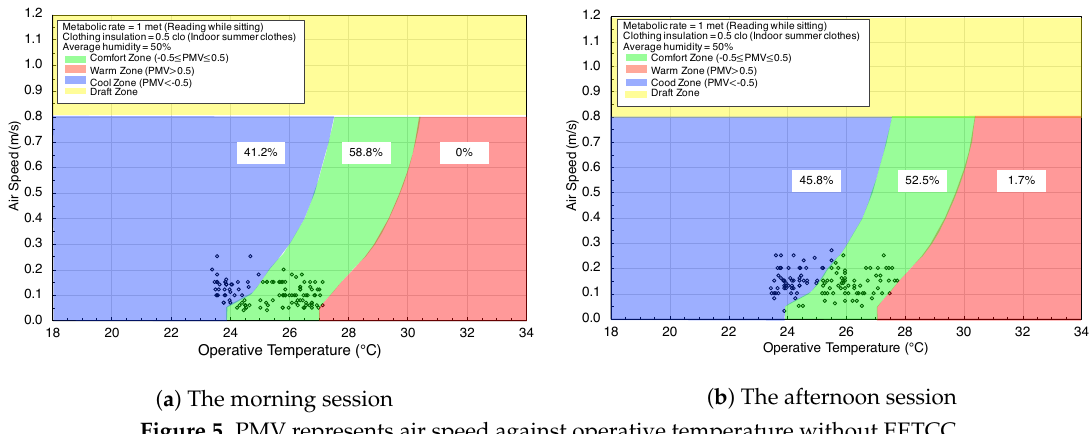
Figure 5. PMV represents air speed against operative temperature without EETCC.